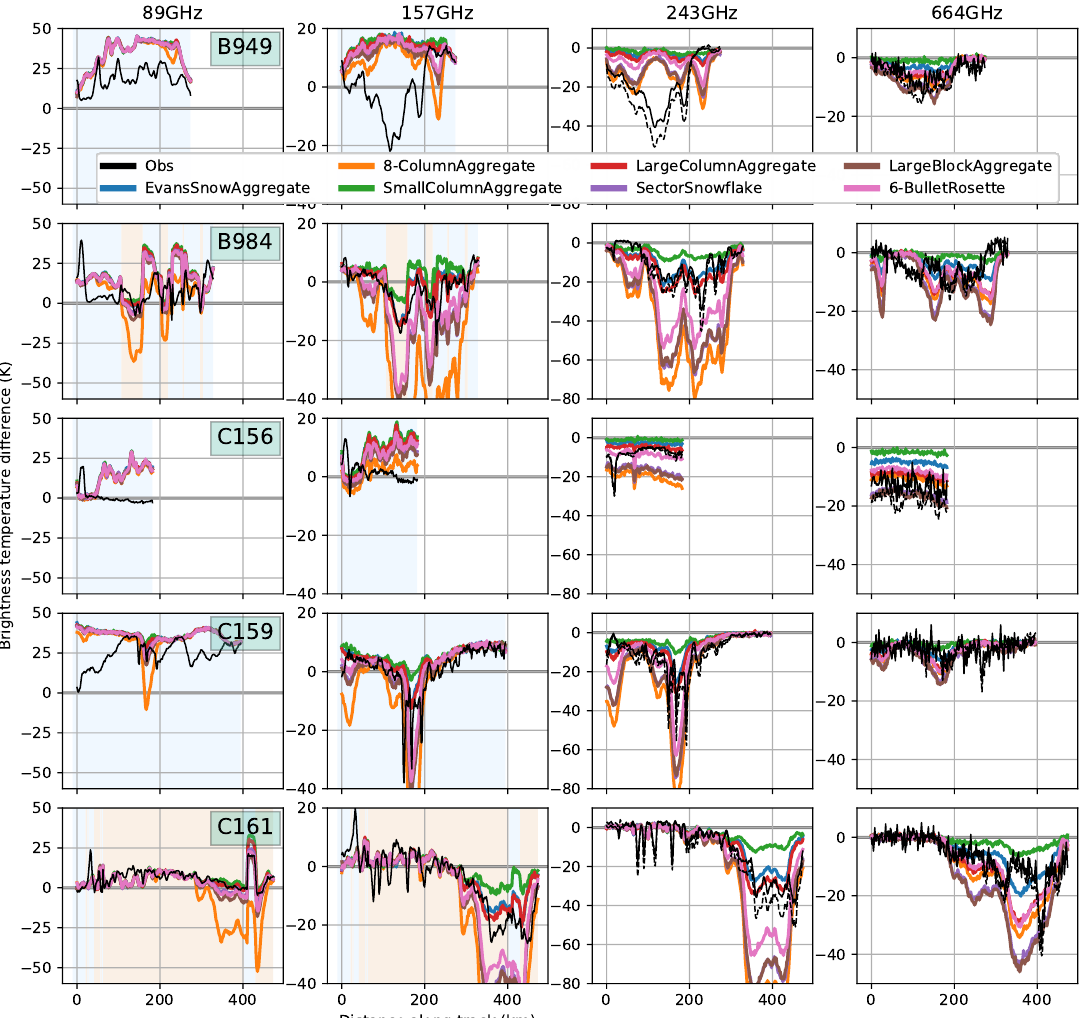
Figure 6. Cloud-induced brightness temperature differences for selected channels for all flights. The coloured lines show the difference between simulated cloudy brightness temperatures and simulated equivalent clear-sky brightness temperatures. The black lines show the difference between observed brightness temperatures and simulated equivalent clear-sky brightness temperatures. On the 243 and 664 GHz plots the dashed black lines represent the horizontally-polarised observations, and the solid black lines represent the vertically-polarised observations. The shaded background on the 89 and 157 GHz plots represents the primary surface type (sea=blue, land=beige). Note that different vertical scales are used for each